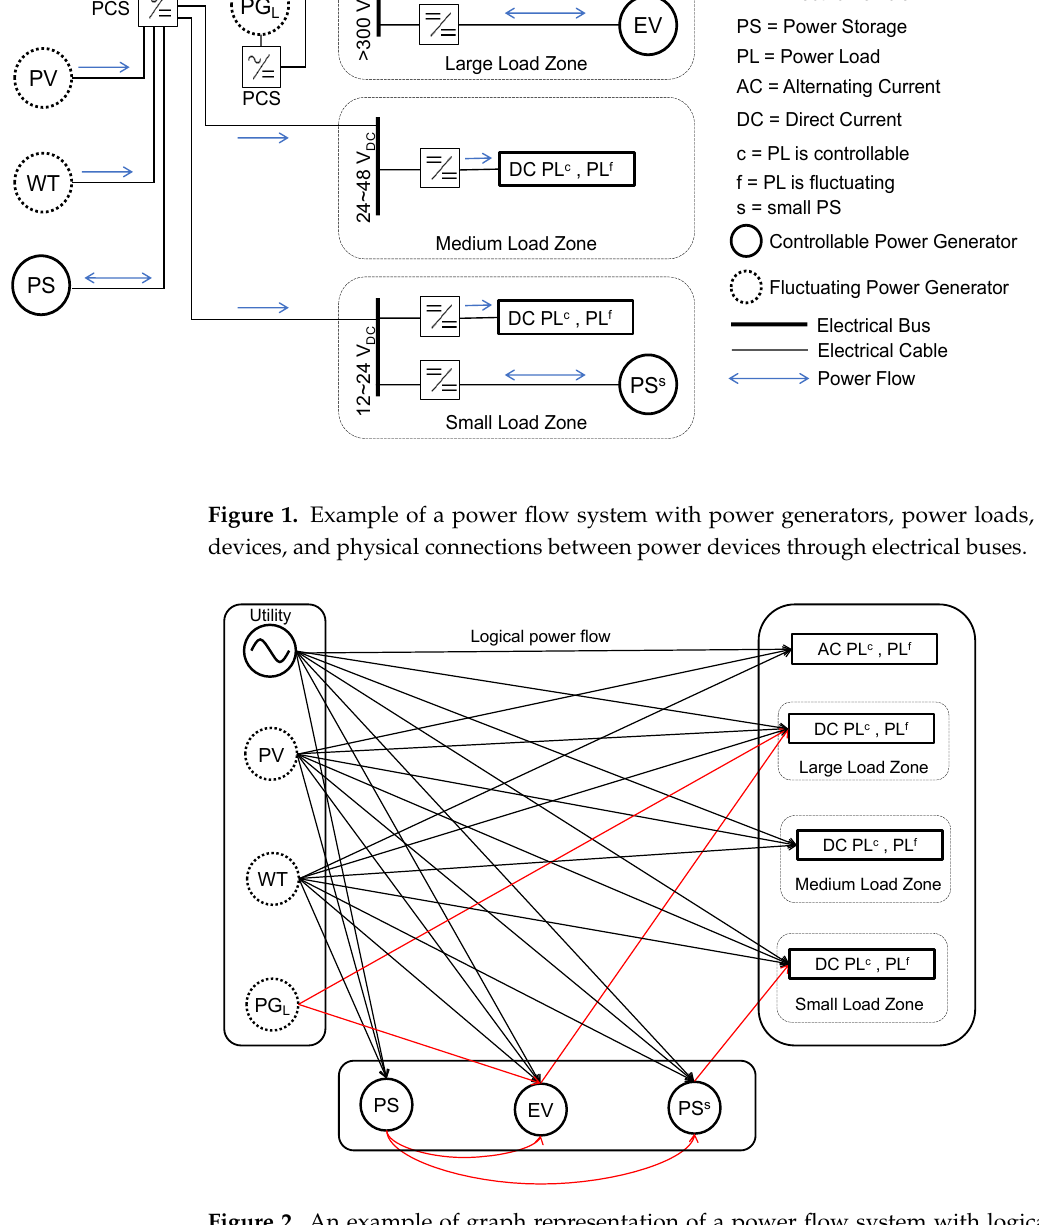
Figure 2. An example of graph representation of a power flow system with logical power flows between power devices. The above graph consists of 3 subsets of nodes; 1st subset is for power generators, 2nd subset is of power loads, and 3rd subset is for power storage devices. The connections between two devices represent the logical connection for power flow. For example, PV in Figure 1 can provide power to all loads and storage devices. In this figure, PV is also connected to all power loads and storage devices. On the other hand, PG L can supply power to the loads in large zone and EV in Figure 1. Therefore, the above figure also shows connection from PG L to power loads in large zone and EV. All the other connections are designed in the same way from Figure 1. A general model will be shown in Figure